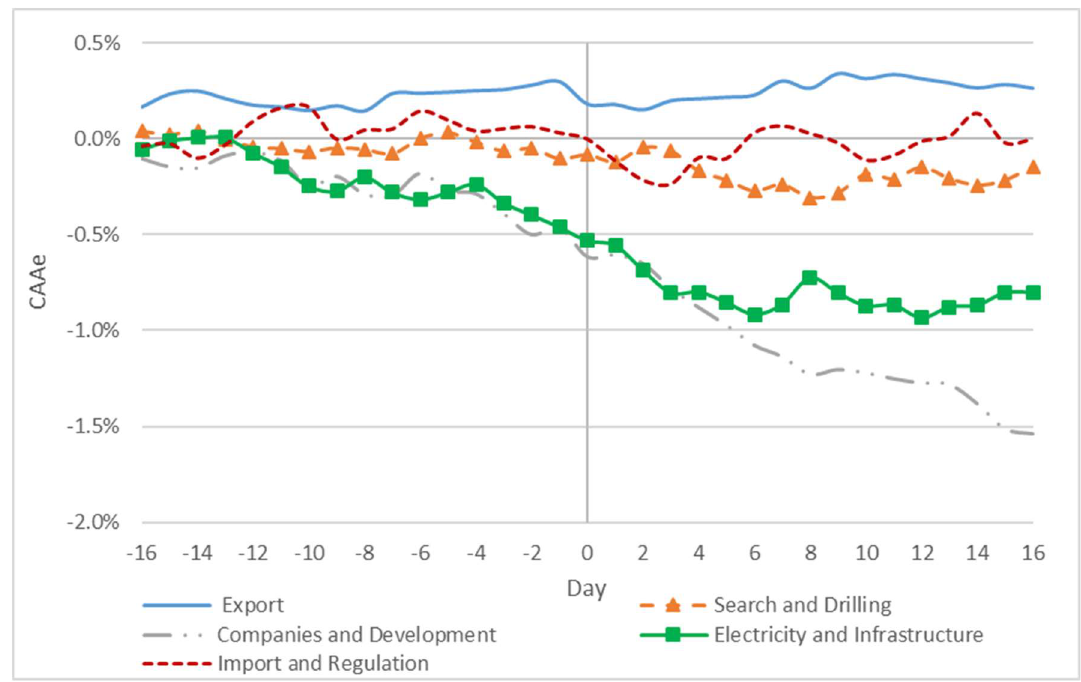
Figure 4. The CAAe behavior during the 33-day event window surrounding the event day for the entire sample of 296 announcements by five announcement types.